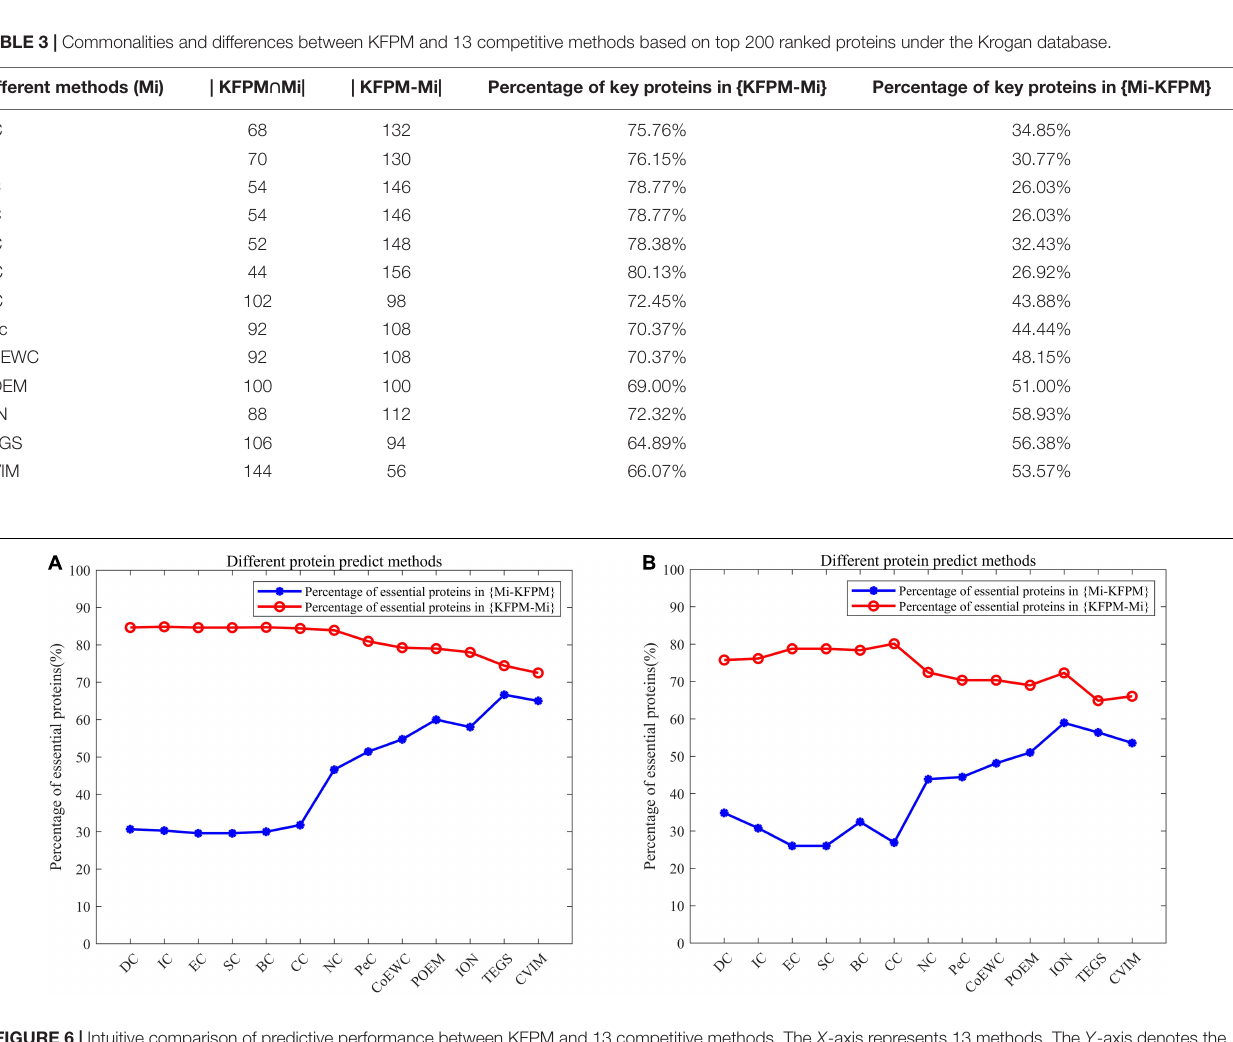
Frontiers in Genetics |